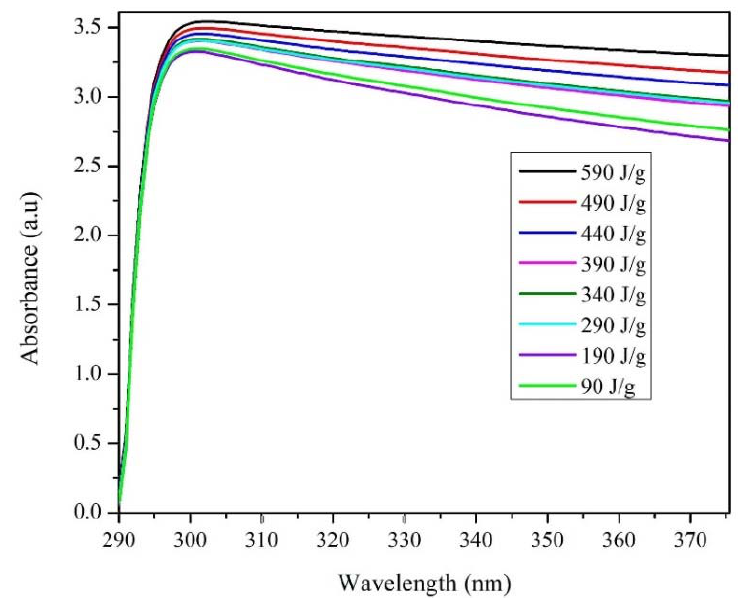
Figure 5. Evolution of UV ‐ vis spectra in an aqueous solution at 0.35% in MWCNTs weight with 10 mM of TX ‐ 100 concentration as a function of sonicator energy.